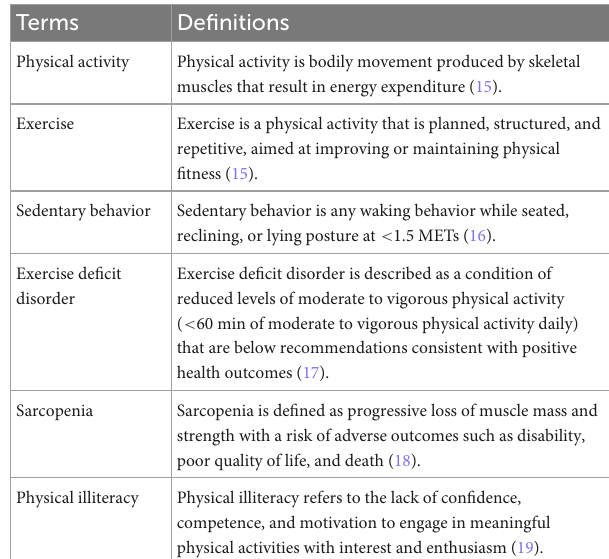
TABLE 1 Definitions of related